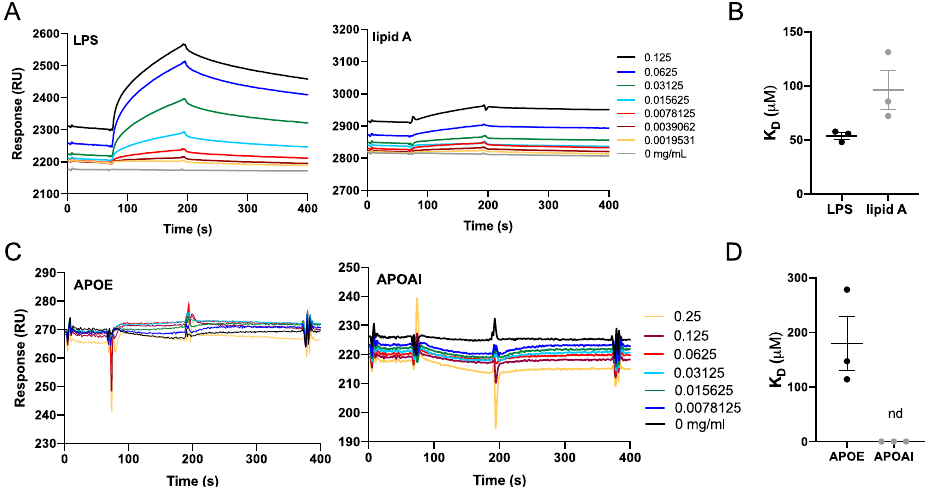
Figure 3. Biacore binding analysis. Binding interactions between the analytes and immobilized APOE protein or LPS. ( A , B ) Sensorgrams that show the response unit plotted as a function of time for LPS and lipid A or for APOE and APOAI. ( C , D ) Dissociation constants (K D ) of protein–ligand interactions were calculated from the sensorgrams (nd = not detected).